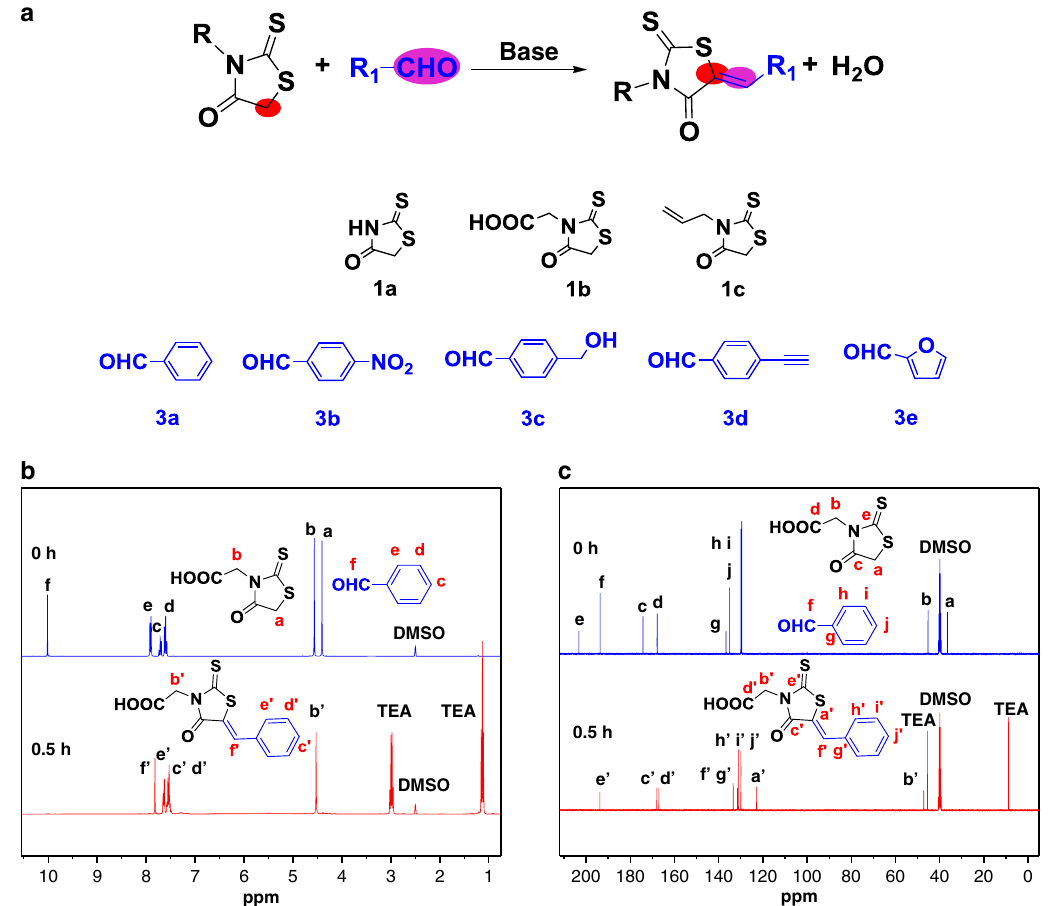
Fig. 4 Rhodanine – aldehyde (RA) Knoevenagel reaction. a RA reaction and chemicals b 1 H NMR and c 13 C NMR results of RA reaction between 1b and 3a.